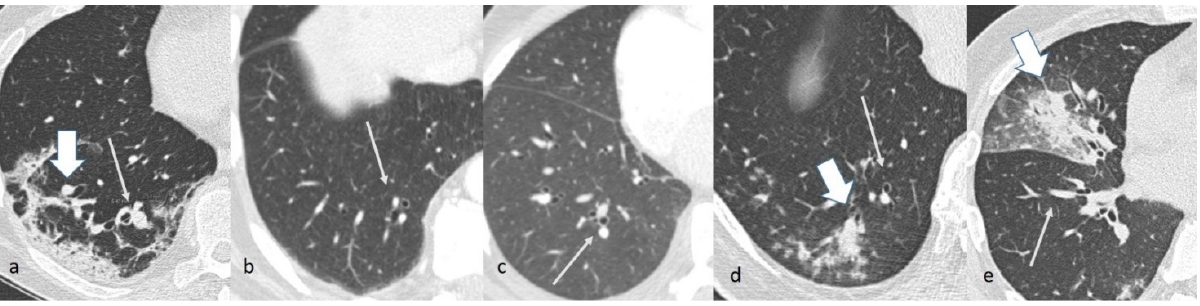
Figure 3. Chest CT images of patients in, respectively, group COV-P ( a ), NL ( b ), DTE ( c ), Bact-P ( d ), and Fung-P ( e ). Note the segmental branches of the pulmonary artery and the corresponding bronchus on the healthy parenchyma (thin arrows ( a – e )) and the area of lung opacification (wide arrows ( a , d , e )).